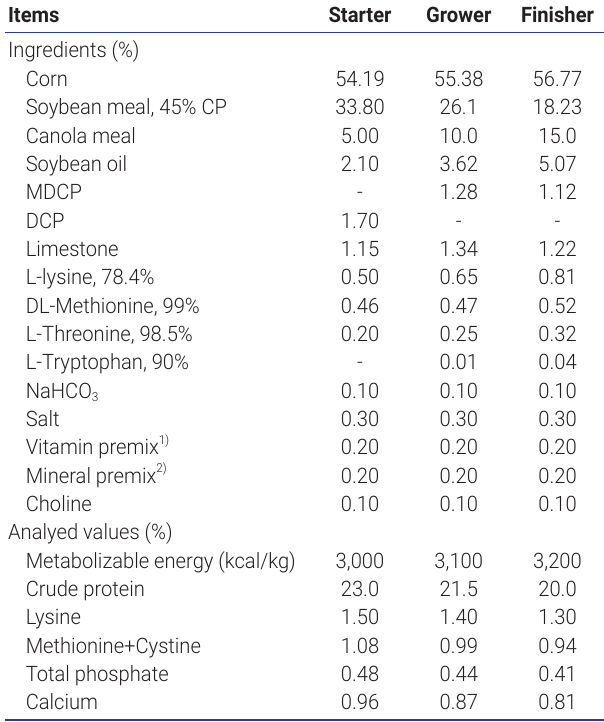
Table 1. Ingredient composition of experimental diets as-fed basis